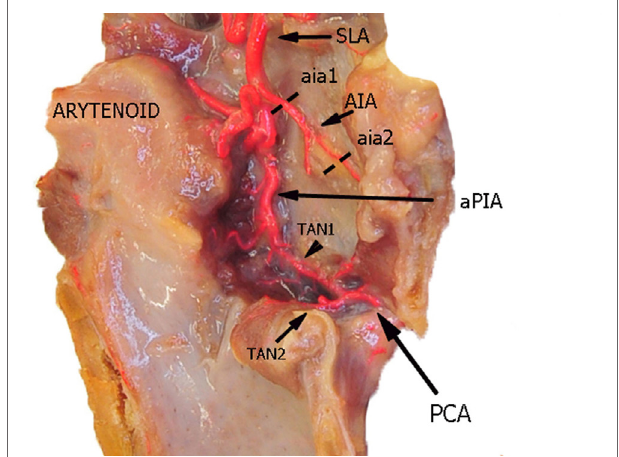
Figure 2 | Left fresh-frozen cadaver hemilarynx after midline section of the cricoid and thyroid cartilages. The ipsilateral arytenoid was left in place, while left aryepiglottic, false, true vocal folds, and paraglottic fat tissue had been removed, thus exposing the inner thyroid lamina. Bicomponent red silicone had been injected in the left common carotid and subclavian arteries. Dotted lines aia1 and aia2 are those used for measurements of the AIA. Abbreviations: SLA, superior laryngeal artery; AIA, antero-inferior artery; aPIA, anterior branch of the postero-inferior artery; PCA, paracommissural branch of the crico–thyroid artery; TAN1, lateral transverse anastomotic network; TAN2, medial transverse anastomotic network.